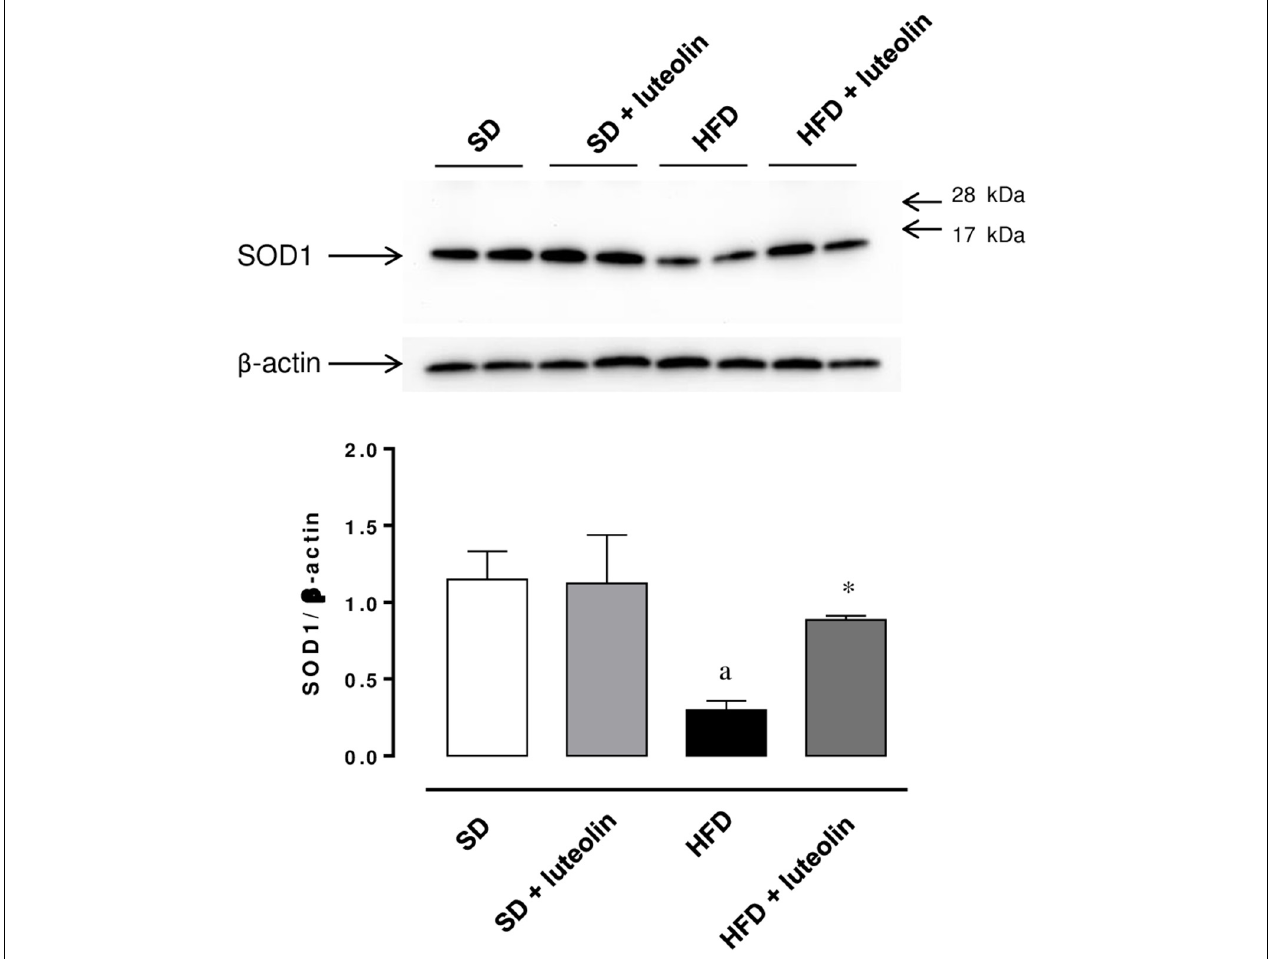
FIGURE 8 | Western blot analysis of SOD1 expression in mesenteric arteries from mice fed with SD, SD plus treatment with luteolin (10 mg/Kg/day), HFD or HFD plus treatment with luteolin (10 mg/Kg/day) for 8 weeks. The figure displays representative blots and column graph referring to the densitometric analysis of immunoreactive bands of SOD1 normalized to the expression of β -actin. Each column represents the mean ± SEM of five animals. a P < 0.05, significant difference vs. SD; ∗ P < 0.05 significant difference vs. HFD. Statistics: two-way analysis of variance followed by Newman–Keuls